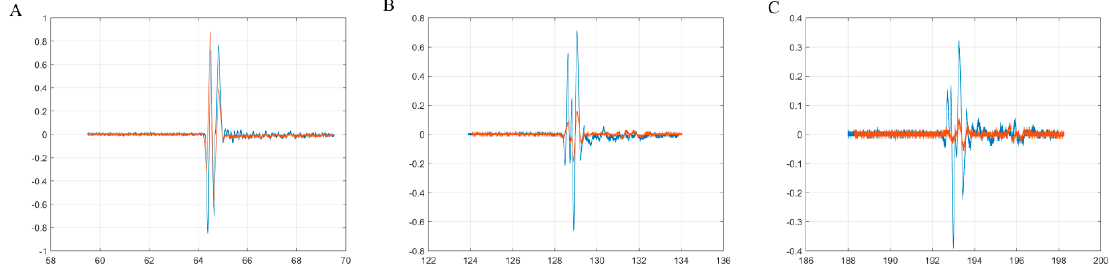
Figure 4. Detailed comparison between the first three echoes registered for double-distilled water (blue) and CD-HAp_1 solution (orange). First echo ( A ), second echo ( B ) and third echo ( C ).